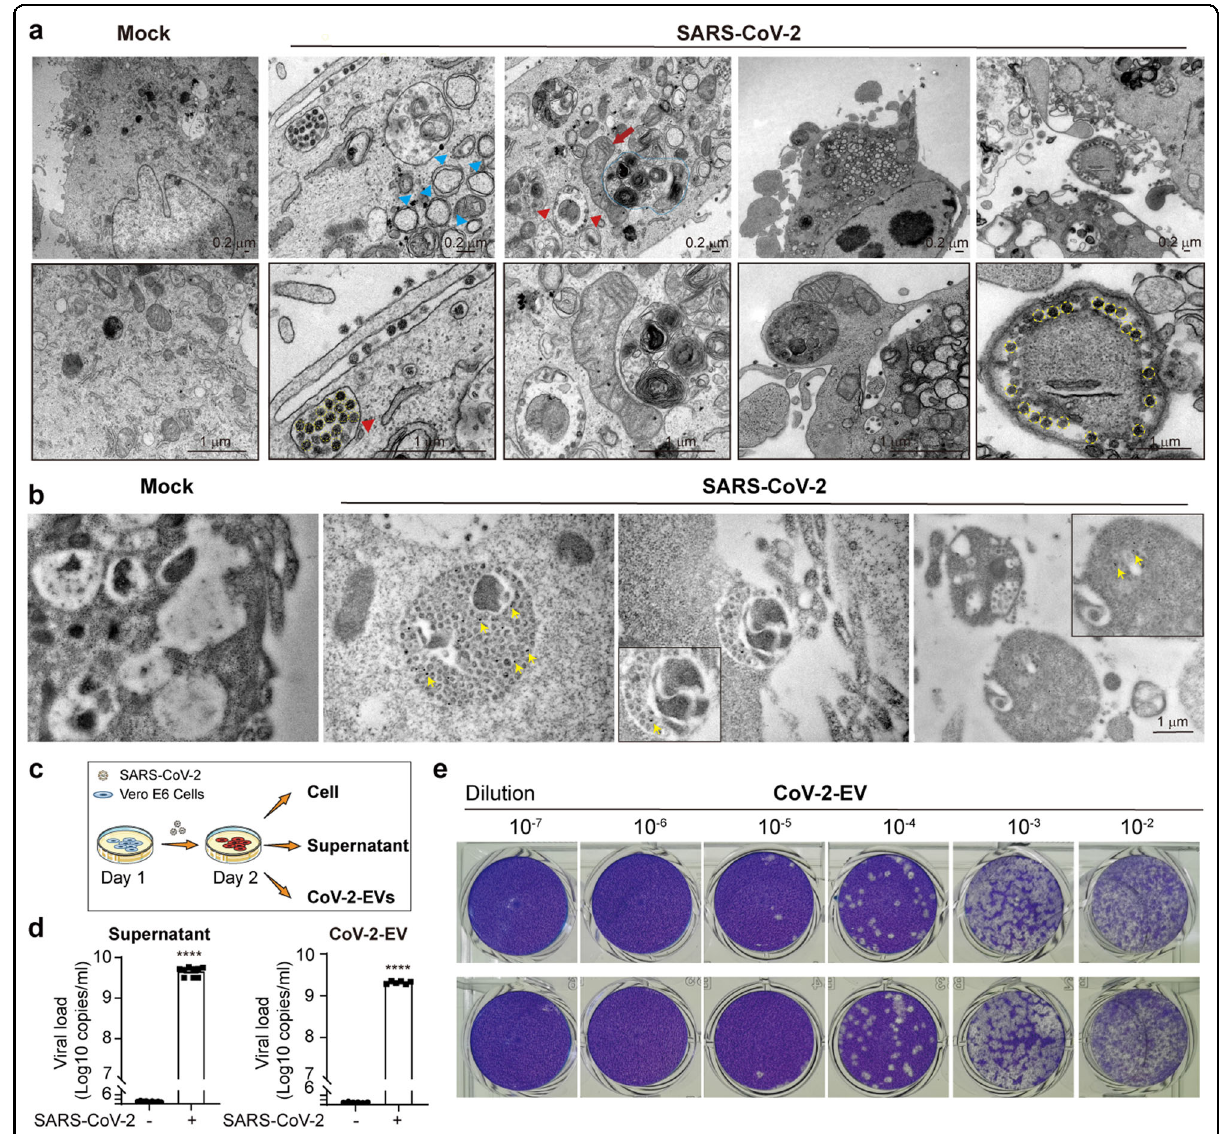
Fig. 3 CoV-2-EVs contain a large amount of virus particles. a TEM images of Vero E6 cells infected with SARS-CoV-2. Blue triangles, double- membrane vesicles (DMVs); red triangles, SMVs; yellow dotted circles, virus particles; red arrow, damaged mitochondria; blue dotted circle, lysosomes (MOI = 1). b Immunoelectron microscopy analyses of infected Vero E6 cells using SARS-CoV-2 nucleocapsid immunogold labeling (MOI = 1). Yellow arrows, virus particles. c Schematic representation of infection experiments. Vero E6 cells were infected with SARS-CoV-2. On the next day, the cells, supernatant, and CoV-2-EVs were collected. d qRT-PCR analysis of SARS-CoV-2 RNA in supernatant and isolated EVs from SARS-CoV-2-infected Vero E6 cells. e Plaque reduction assay of CoV-2-EVs. Data are the means ± SEM. * P < 0.05, ** P < 0.01, *** P < 0.001, **** P < 0.0001; unpaired Student ’ s t